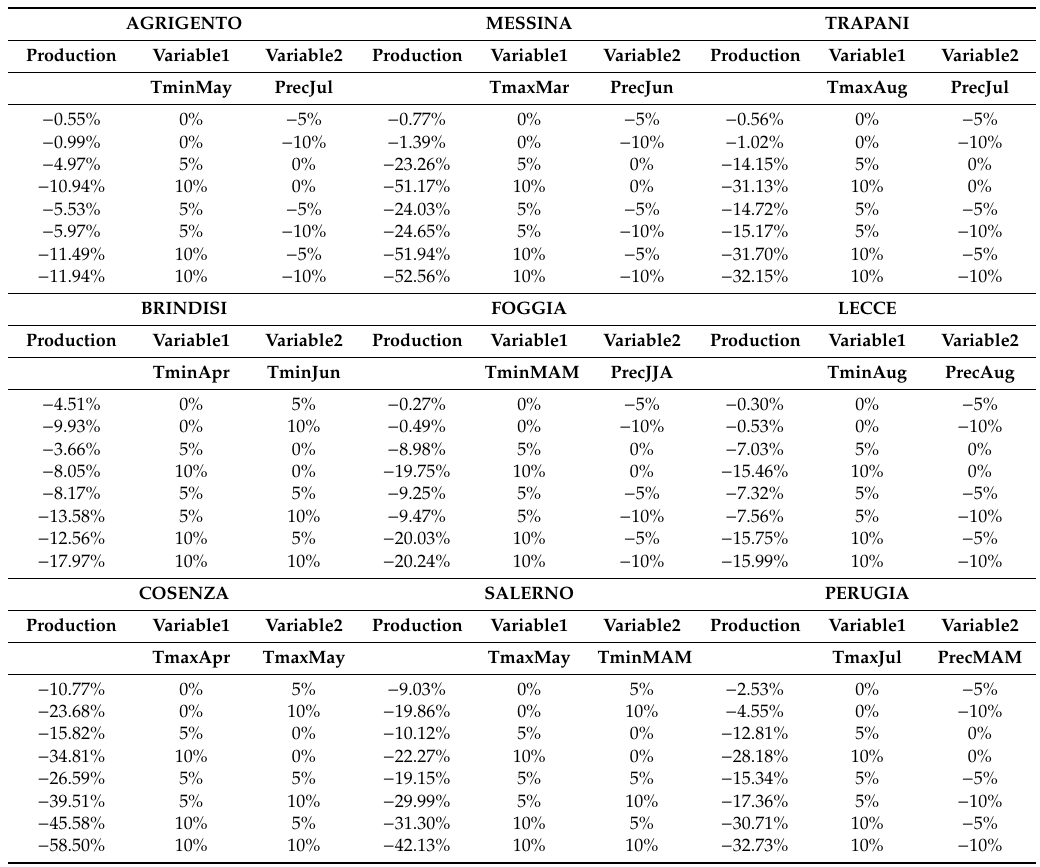
Table 3. Reduction of olive fruit production based on hypothetical changes in predictive variables of the models showed in Table 2. Abbreviations: Tmax, maximum temperature; Tmin,